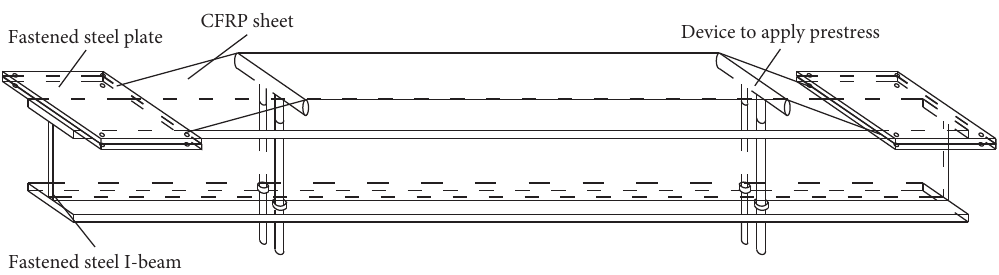
Figure 2: Device for applying prestress to CFRP sheet.